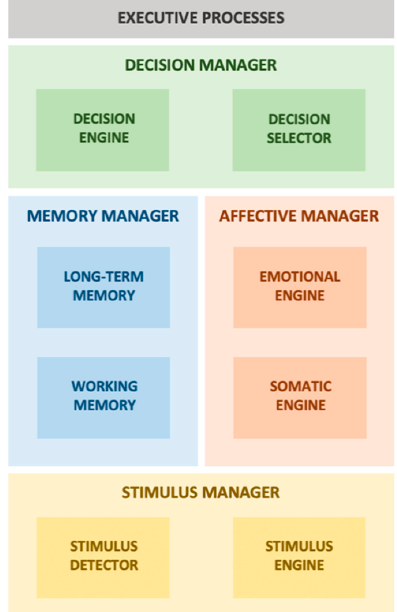
Figure 3. General architecture for considering artificial somatic markers within decision making.